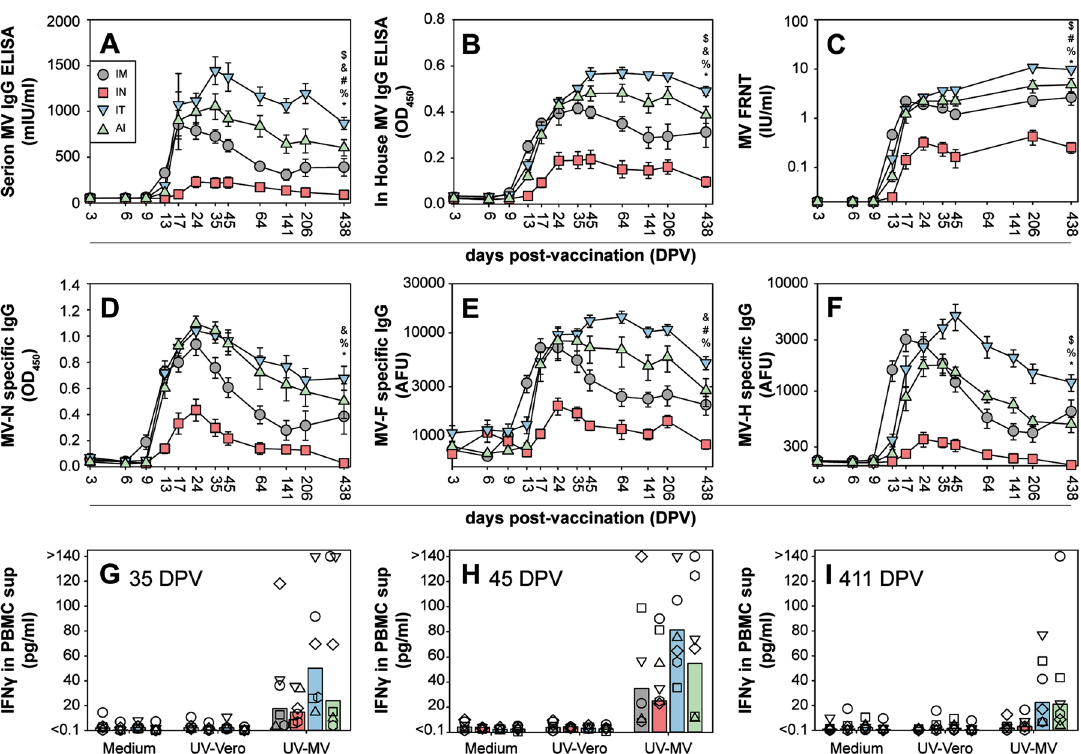
Fig. 4 Immunogenicity. Virus-speci fi c immune responses after immunization of non-human primates with rMV EZ EGFP(3) via four different routes of administration. Panels a – f show MV-speci fi c serum antibody responses measured by six different assays: a Serion IgG ELISA, with results expressed in milli-international units per ml (mIU/ml); b in house MV IgG ELISA, with results expressed in optical density at 450 nm (OD 450 ); c focus reduction neutralization test ( FRNT ), with results expressed in international units per ml (IU/ml); d MV nucleoprotein ( MV - N )- speci fi c IgG ELISA, with results expressed in OD 450 ; e MV fusion (MV-F) glycoprotein-speci fi c FACS-measured IgG immuno fl uorescence (expressed in arbitrary fl uorescence units, AFU); f MV hemagglutinin ( MV - H ) glycoprotein-speci fi c FACS-measured IgG immuno fl uorescence (expressed in AFU). Results are shown as means ± standard error of six animals per group. Panels g – i show MV-speci fi c cellular responses measured using PBMC collected 35 ( g) , 45 ( h ), or 411 ( i ) DPV. Brie fl y, PBMC were stimulated with UV-inactivated MV (UV-MV), mock antigen (UV-Vero) or medium. Culture supernatants were harvested after 2 days for measurement of the concentration of IFN- γ by ELISA. Bars represent the means, while symbols represent responses of individual animals. Results of statistical analysis (Two-way analysis of variance with Tukey ’ s multiple comparison test) are indicated by the following symbols if P -values were below 0.05: $ (IM vs. IT),! (IM vs. AI), and (IM vs. IN), # (IT vs. AI), % (IT vs. IN), * (AI vs.